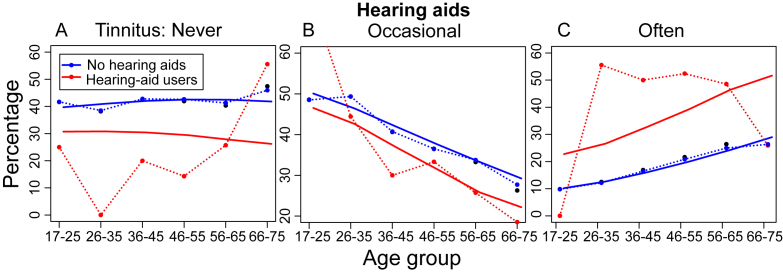
Hearing aid use and tinnitus prevalence. Details as per Fig. 3. Model: Tinnitus ∼ Age + Hearing Aid.